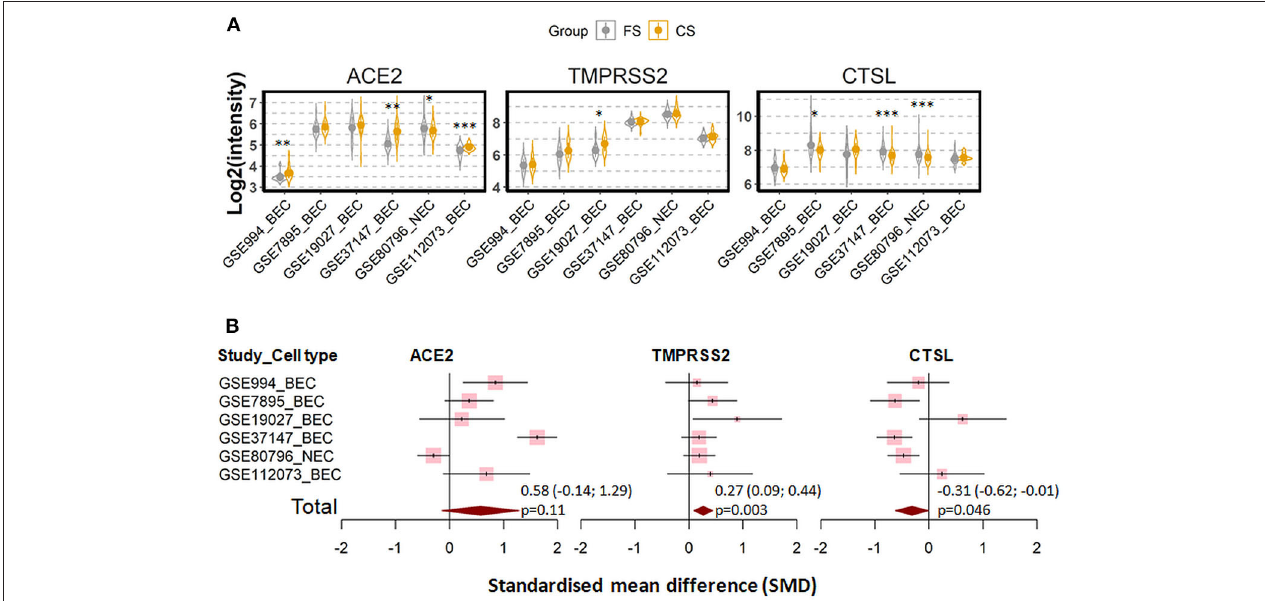
FIGURE 3 | Expression of ACE2, TMRPSS2, and cathepsin L (CTSL) in airway epithelial cells of healthy current smokers (CS) and former smokers (FS). (A) Violin plot of expression levels of ACE2, TMPRSS2, and CTSL in six datasets which contain current smokers and former smoker. The mean and standard deviation (SD) of each group were presented as dot and line, respectively. BEC, bronchial epithelial cells; NEC, nasal epithelial cells. Statistical differences were calculated by Student’s t -test. * p < 0.05, ** p < 0.01, *** p < 0.001. (B) Forest plot of six datasets examining expression of ACE2, TMPRSS2, and CTSL in current smokers and former smokers. The x-axis indicates the standardized mean difference (SMD), while the y-axis shows GEO datasets and cell types. Each square in the plots represents the SMD in corresponding datasets and the 95% confidence interval (CI) is showed by the error bar. The size of each square represents the weight of the individual dataset in the meta-analysis. The diamonds in the bottom represent the SMD of the meta-analysis. The SMD, 95% CI and P -values of meta-analysis are depicted.